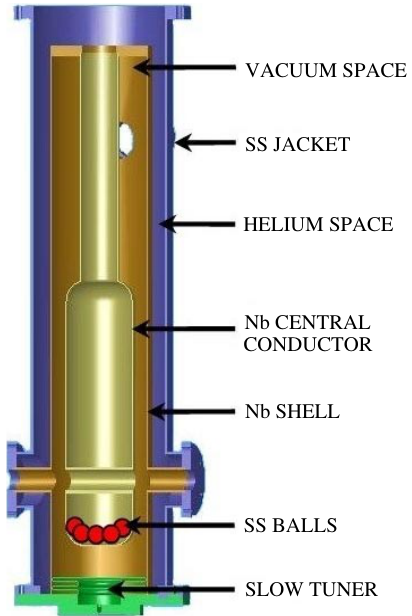
FIG. 1. (Color) Cross-sectional view of a resonator along with a few SS